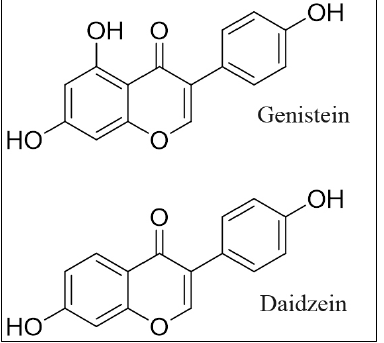
Figure 1. Chemical structure of genistein and daidzein .